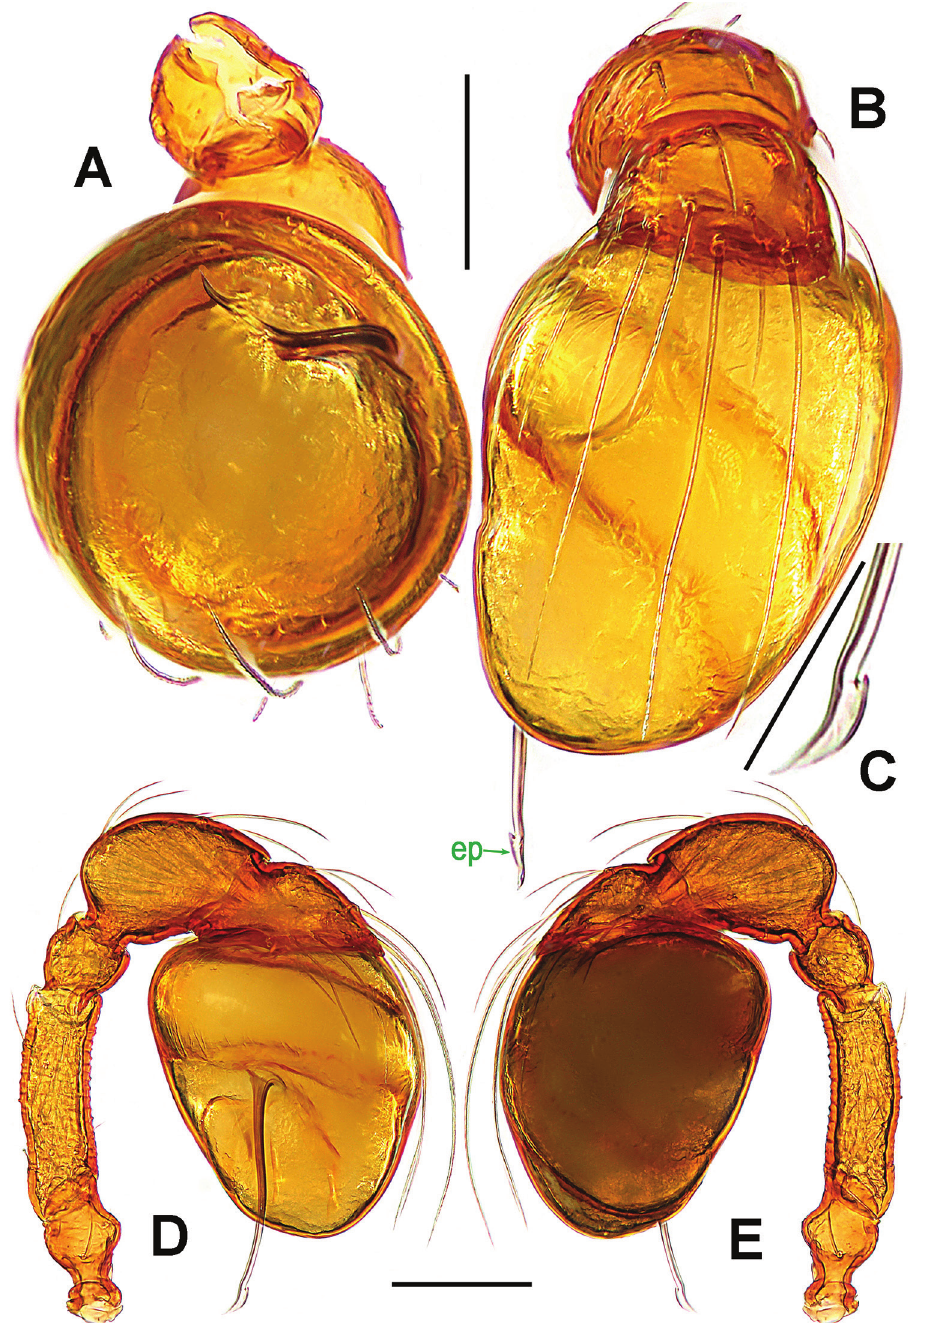
Figure 25. Singaporemma singulare Shear, 1978, male specimen from Singapore. A palpal bulb, ventral B left palp, anterior C embolic end, prolateral D left palp, prolateral E ditto , retrolateral. Abbreviations: ep = embolic part of apes of palpal organ. Scale bars: 0.10